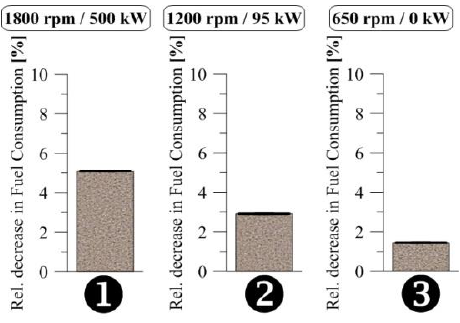
Fig. 11. Hourly fuel consumption FC [l/h] of the CAT C27 engine pow- ered by the base fuel (BASE) and the base fuel with nitrON ® (TEST), for 3 test points F (  )